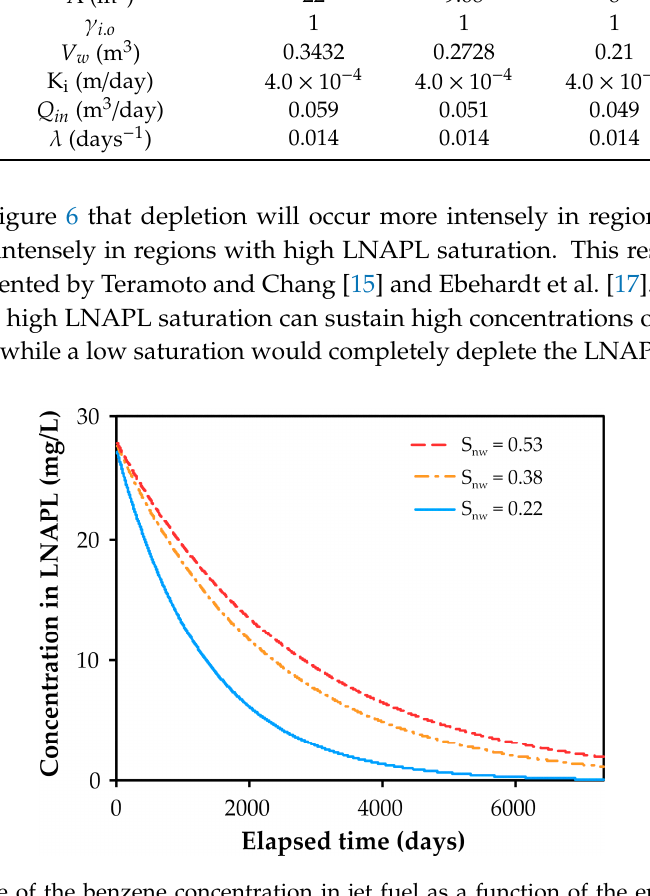
Figure 6. Decline of the benzene concentration in jet fuel as a function of the entrapped LNAPL saturation in the pores ( S nw ).